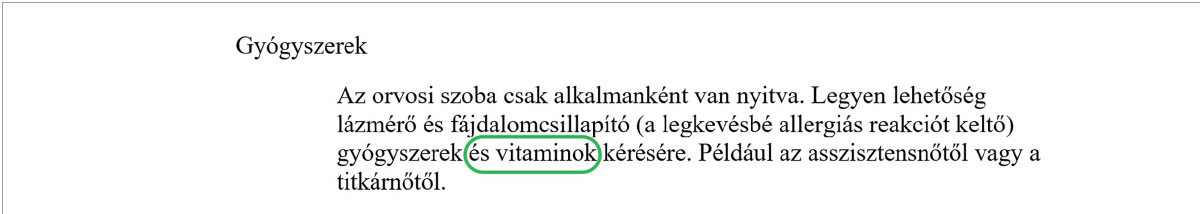
FIGURE5 Position of the new two-word-long expression inserted into the correct text.